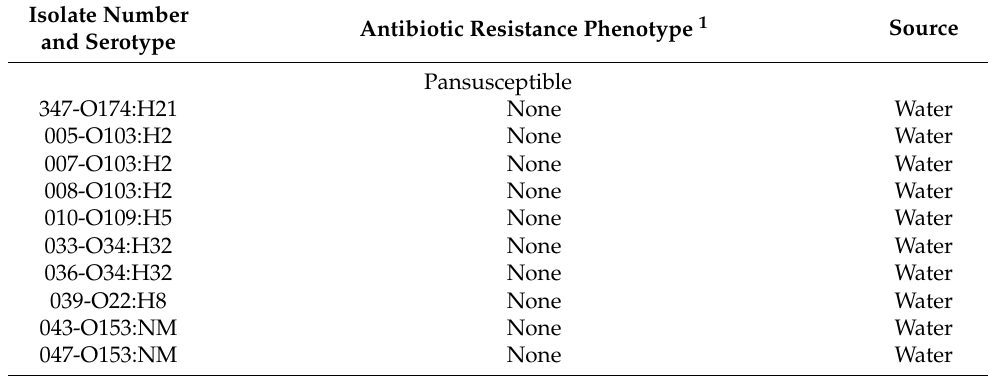
Figure 1. Proportion of 55 Shiga toxigenic Escherichia coli (STEC) isolates that were susceptible, of intermediate resistance or resistant to eighteen antibiotics: amikacin (AMK), amoxicillin/clavulanic acid (AMC), ampicillin (AMP), ceftiofur (TIO), cefoxitin (FOX), ceftriaxone (CRO), ciprofloxacin (CIP), gentamicin (GEN), kanamycin (BCN), nalidixic acid (NAL), streptomycin (STR), trimethoprim- sulfamethoxazole (SXT), chloramphenicol (CHL), tetracycline (TET), imipenem (IPM), ertapenem (ETP), meropenem (MEM) and florfenicol (FFC). Table 1. Antibiotic resistance phenotypes of 55 STEC isolates from surface water and sediments in the Lower Mainland of British Columbia,